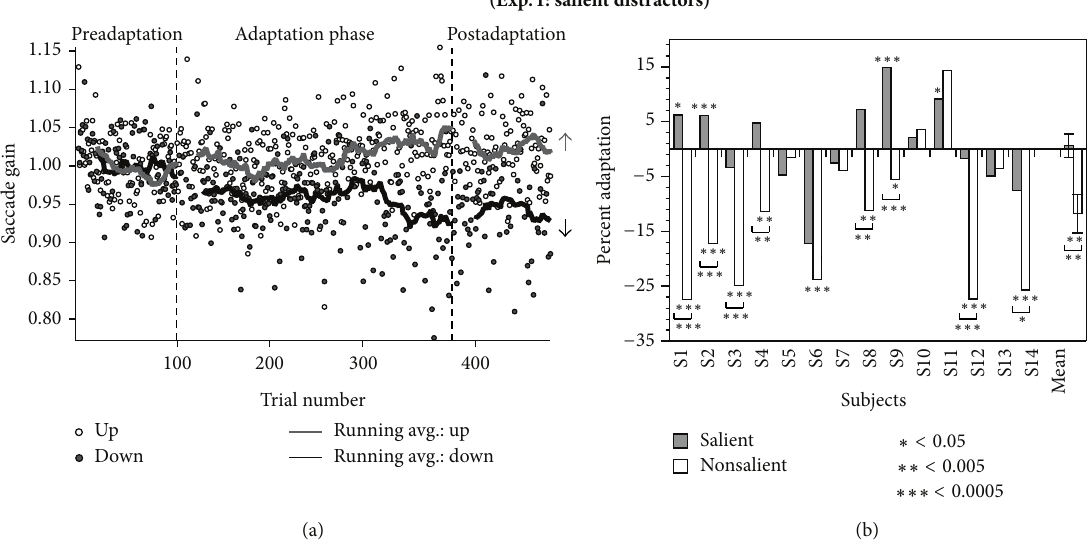
Figure 2: (a) Saccade gain data of subject S1 during Experiment 1 in which distractors consisted of salient images. Gain decreased gradually in the adapt-down condition (Experiment 1(a), closed circles, black curves) and displayed a significant decrease in gain of the postadaptation phase from the preadaptation phase. The adapt-up condition did not demonstrate any significant change (Experiment 1(b), open circles, gray curves). (b) Percentage adaptation (calculated as the difference between the pre- and postadaptation phases relative to the percent of distance of the distractor from the target) for each subject. Mean and standard error across all subjects are shown on the right. The asterisks below or above the bars represent significance between the pre- and postadaption phase in an individual experiment, the asterisks below a square bracket represent the significance between the adaptation in the adapt-down compared to adapt-up